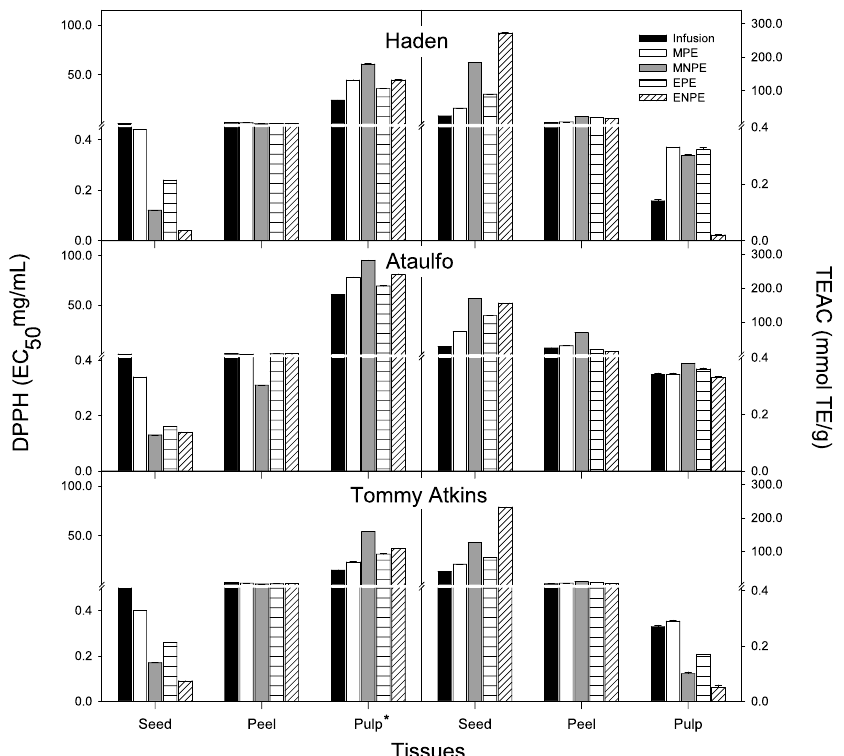
Fig. 2: Antioxidant capacity from fresh-cut mango byproducts extracts. *Average of three determinations ± standard error, **Reported as inhibition % at the concentration 25 mg/mL, because the EC 50 was not